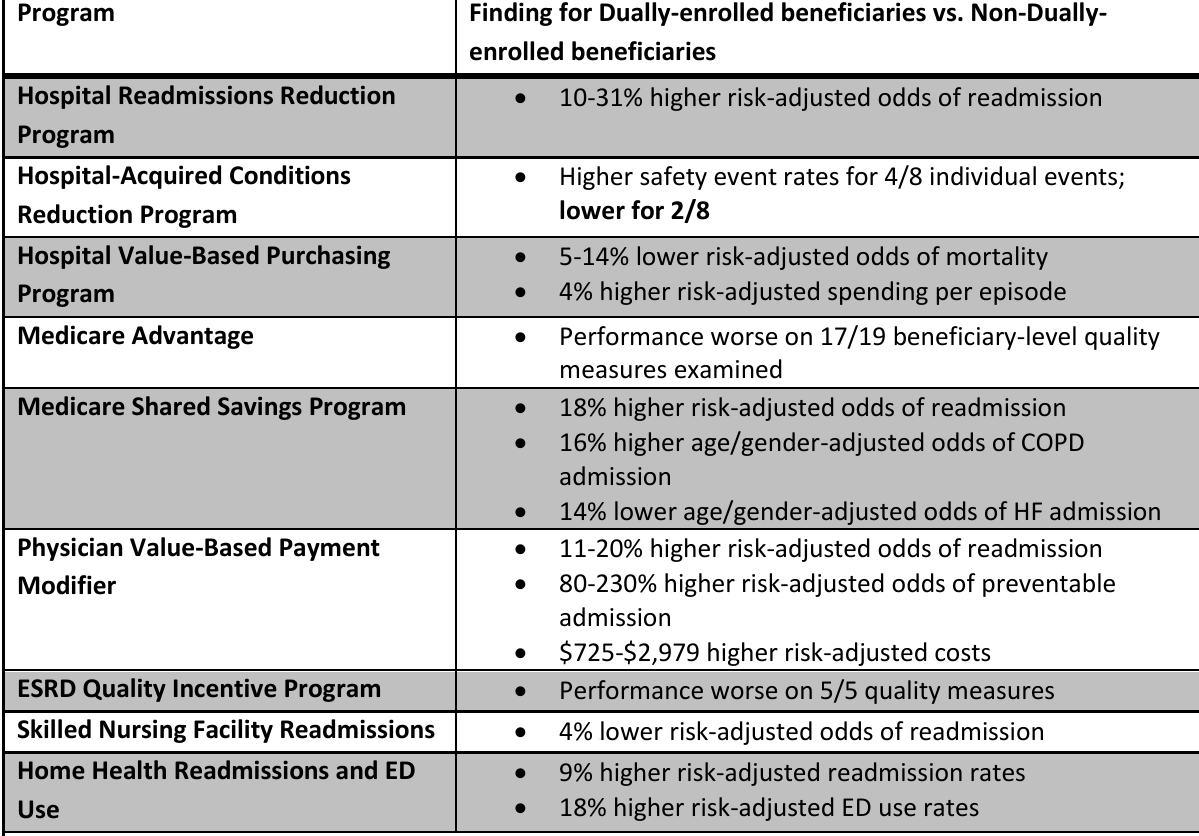
Table 14.1: Relationship Between Dual Enrollment Status and Performance Across Programs Program Finding for Dually-enrolled beneficiaries vs. Non-Dually- enrolled